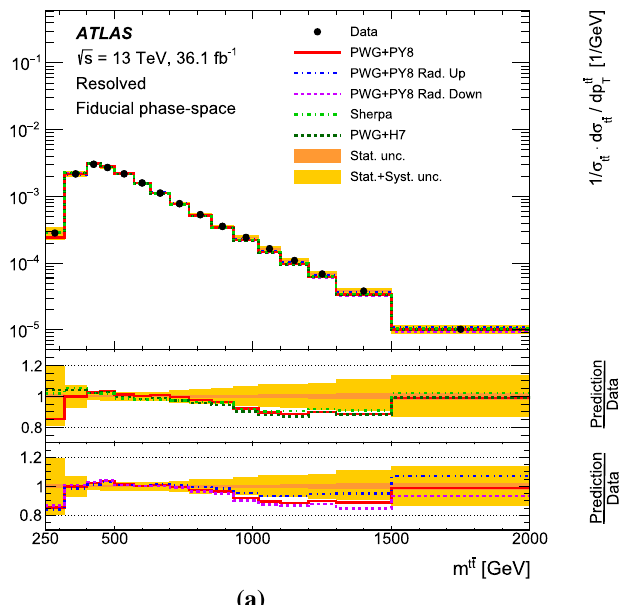
tions. The bands represent the statistical and total uncertainty in the data. Data points are placed at the centre of each bin. The lower panel shows the ratios of the simulations to